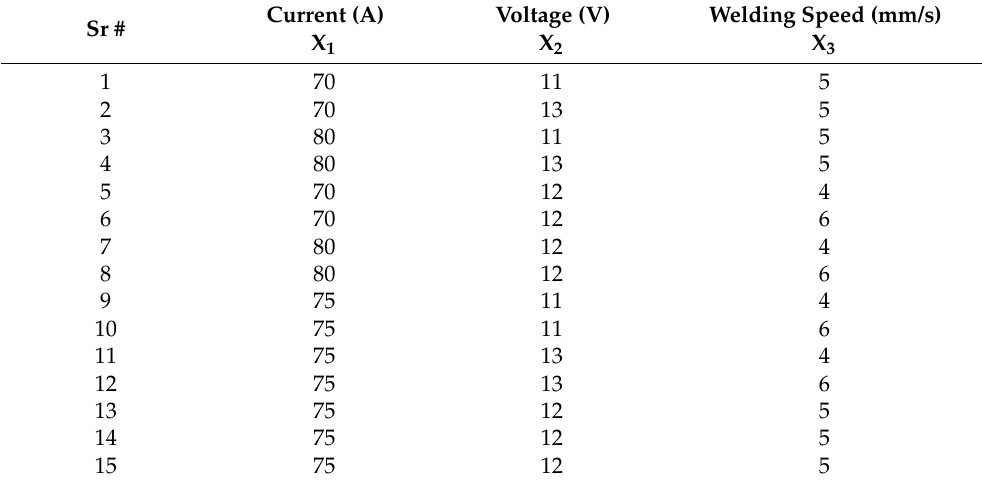
Table 3. The DOE matrix.